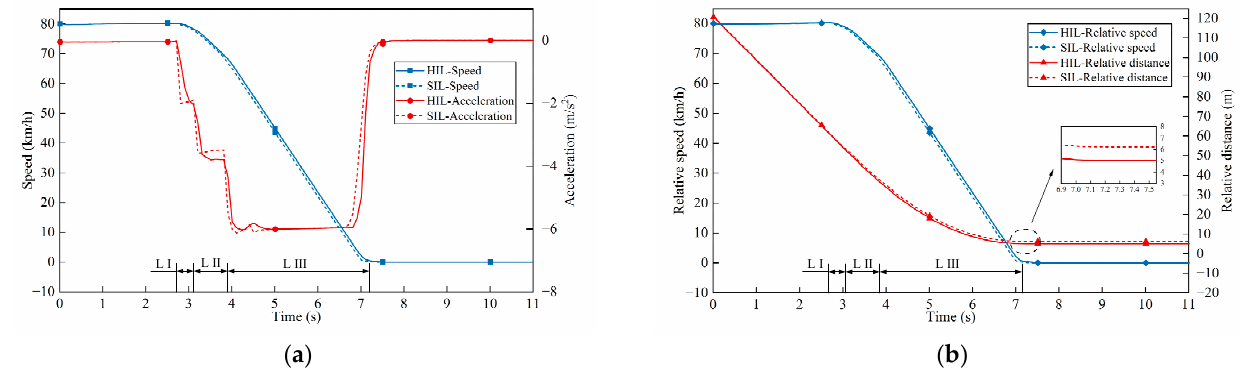
Figure 10. HIL testing and SIL testing results of CCRs condition: ( a ) speed of VUT and acceleration of VUT; ( b ) relative speed and relative distance.